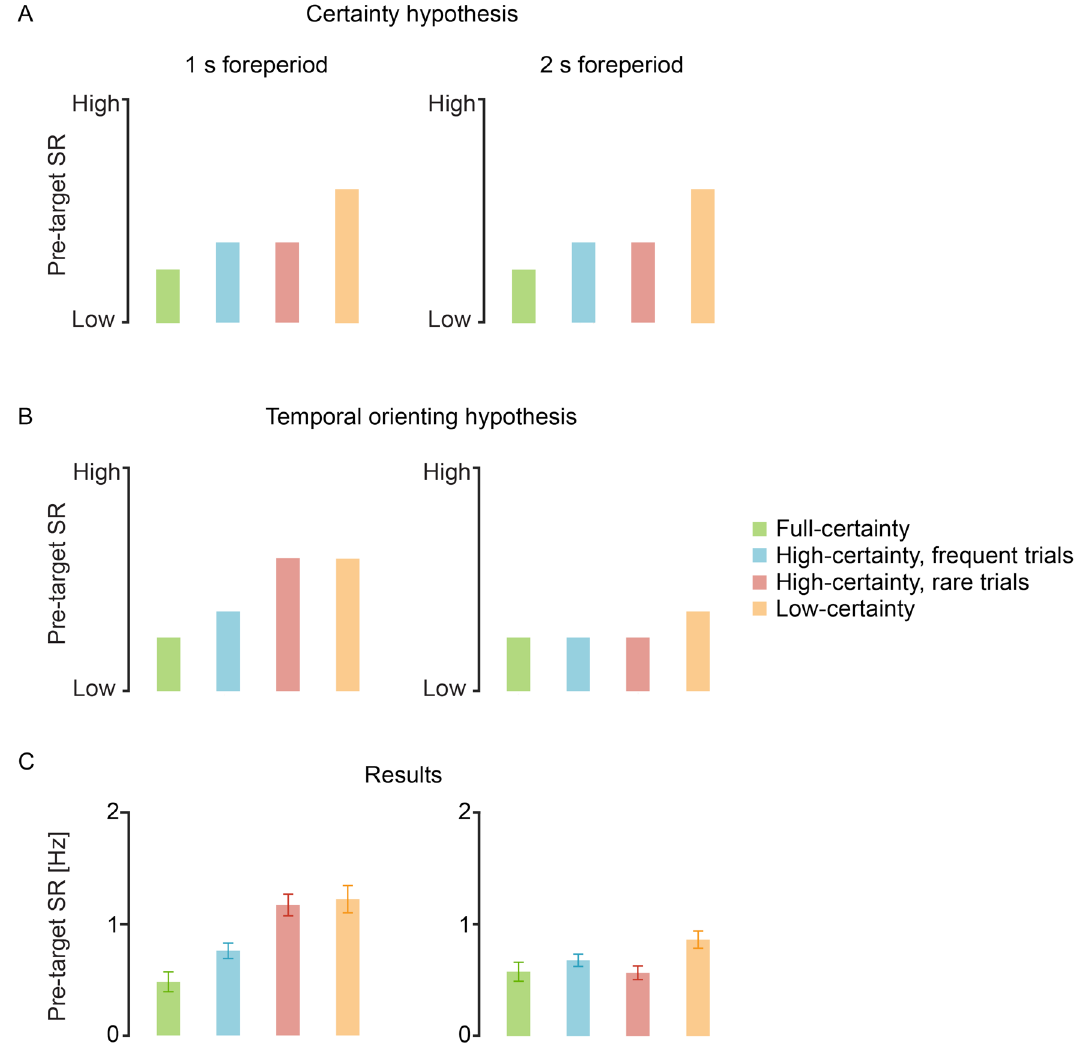
Figure 1. Hypotheses and results. Theoretical predictions of the certainty ( A ) and the temporal orienting ( B ) hypotheses for pre-target saccade-rates (SR) in trials of 1 s (left) and 2 s (right) foreperiod, of the four conditions. ( C ) Grand average pre-target SR of 20 participants, averaged across the time interval of − 100 to 0 ms relative to target onset. Error bars designate ± 1 within-subject standard error from the mean 33 . Statistics were calculated and figure was produced in R 18 using the afex package 19